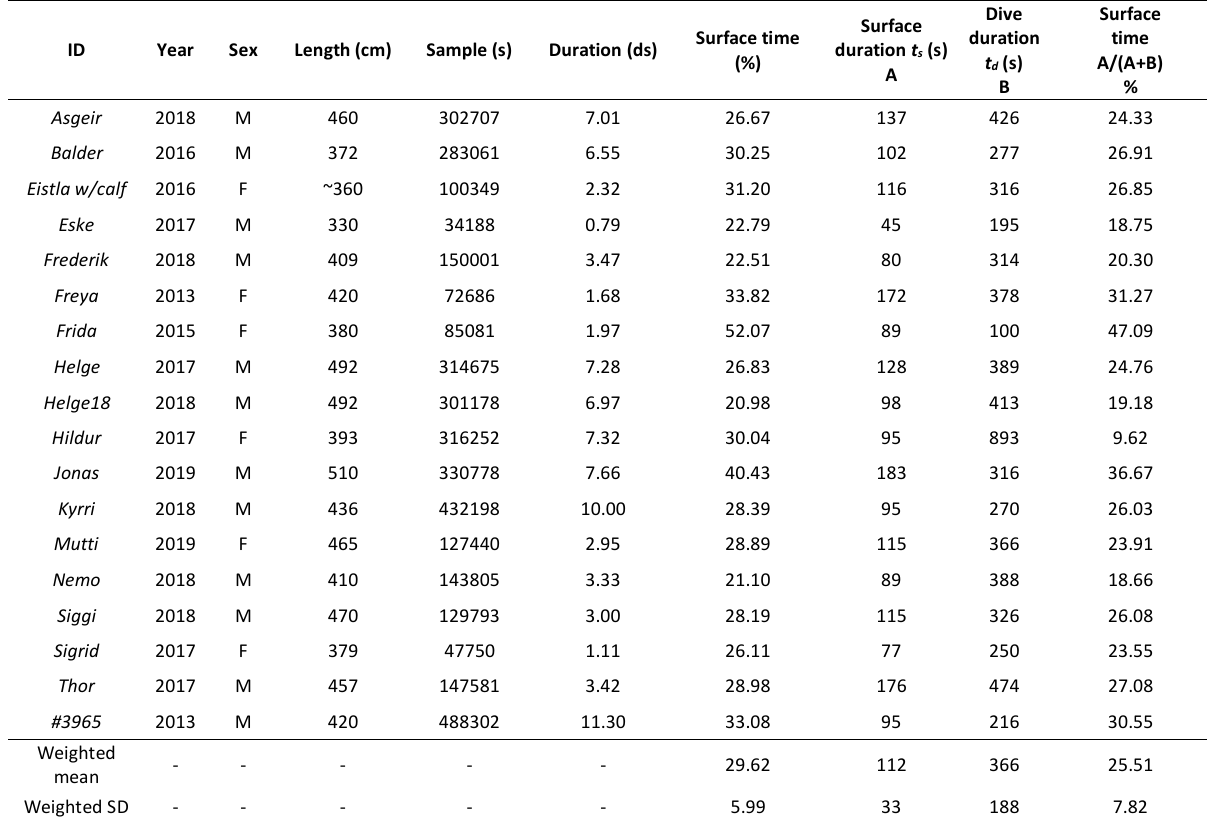
Table 2: List of narwhals from East Greenland that has contributed data on availability bias during summer (August-September). All whales except #3965 were instrumented with Acousonde TM recorders. #3965 was instrumented with a TDR. Only data from between 06:00 and 18:00 were included and the first 24 hr of the recordings were removed to avoid any effects of tagging. Surface time was calculated with Method 1.